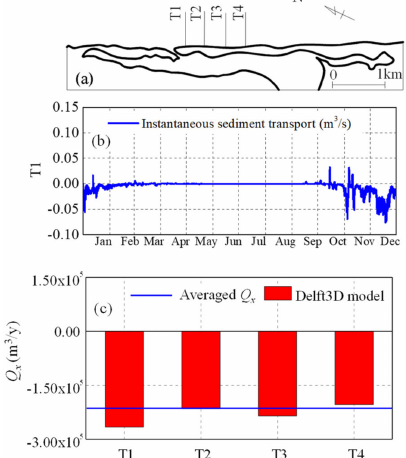
Figure 11. ( a ) Location of profiles. ( b ) Instantaneous sediment transport rate through the T1-profile. ( c ) Total cumulative sediment transport through 4 profiles at the An Du sand spit.